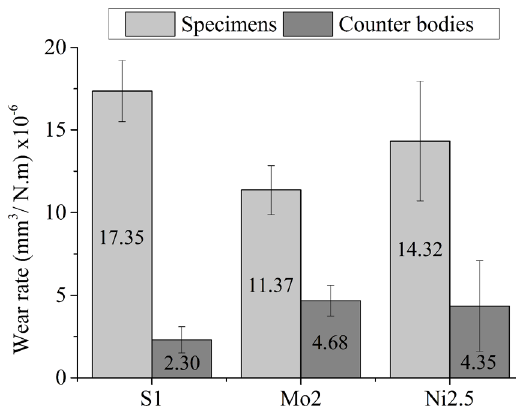
Figure 7. Wear rates for the specimens after reciprocating sliding for 1h. The Mo425 sample presented the best performance. The error bars means the standard deviation of the wear